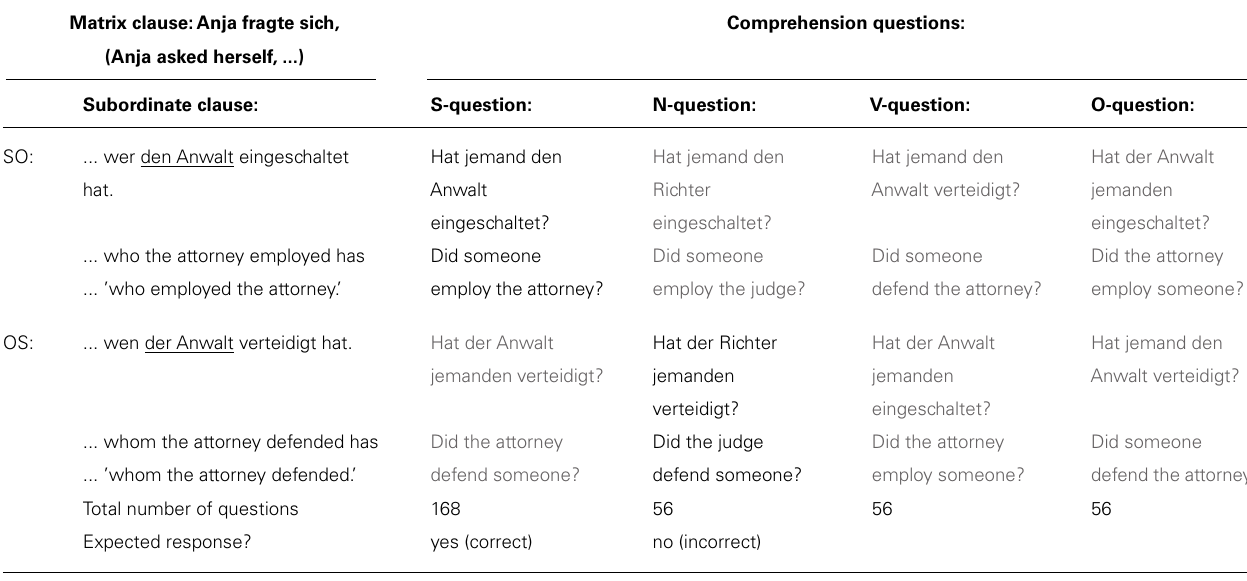
Table 3 | Set of experimental stimuli consisting of a matrix clause ([proper name] asked himself/herself...) and an embedded subordinate clause. Matrix clause:Anja fragte